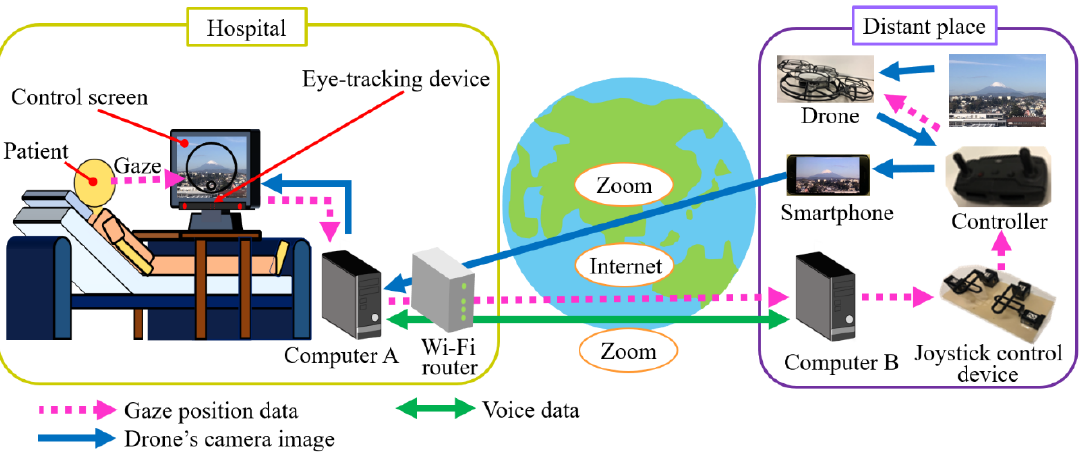
Figure 1. Remote-controlled drone